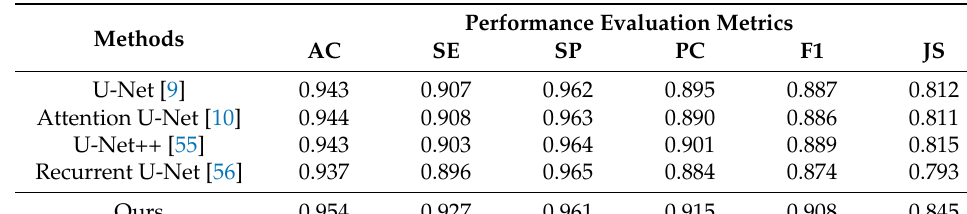
Table 2. Performance comparison between the proposed network and other methods on the ISIC- 2016 dataset.